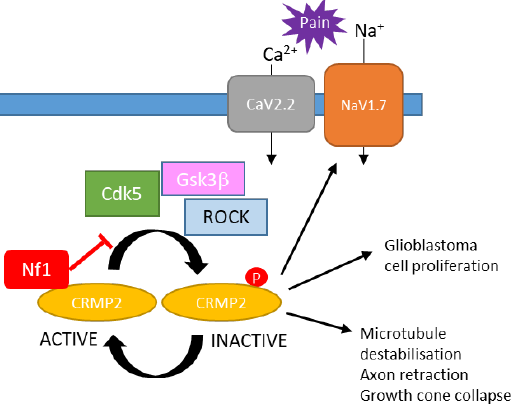
Figure 15. Schematic representation of the mechanisms for neurofibromin-mediated inhibition of CRMP2 phosphorylation and inactivation [59,145].